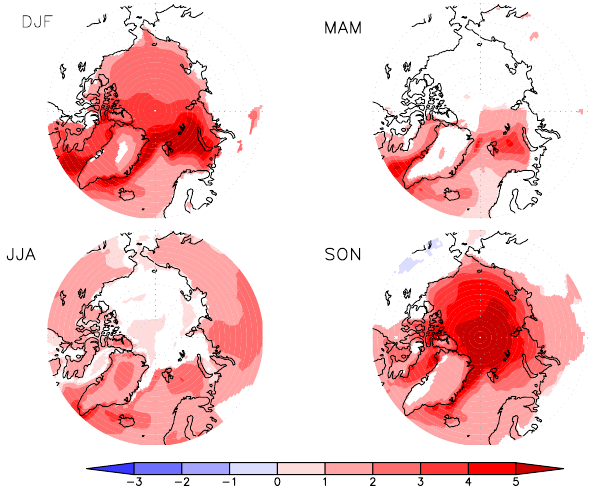
Fig. 13. Change in surface temperature ( ◦ C) north of 60 ◦ N from mid-Holocene to pre-industrial in the MIROC-ESM, for winter, spring, summer and autumn. Only changes statistically significant at a 95% confidence level are shown. The strongest temperature responses occur in winter and spring, where the mid-Holocene cli- mate is colder than the